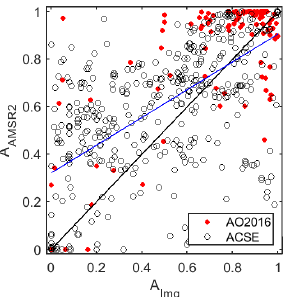
Figure 5. A comparison of the ice fraction derived from the local imagery and from AMSR2 for both field campaigns. The linear re- gression ( A AMSR = 0.584 A Img + 0.321) and 1 : 1 lines are shown in blue and black